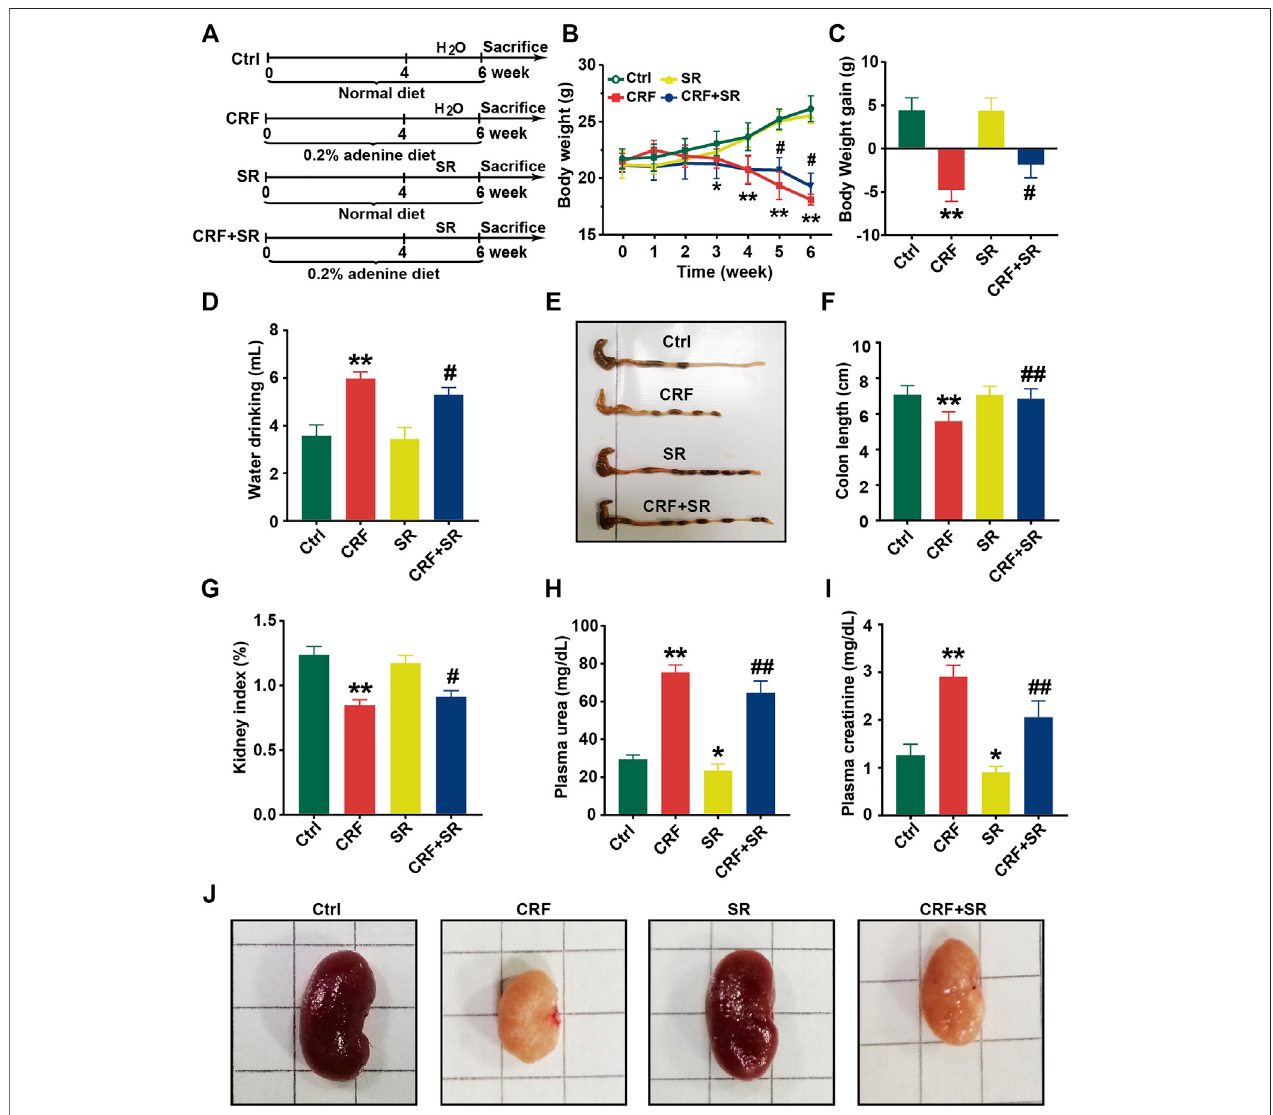
FIGURE 2 | Improvement of physiochemical parameters in adenine-induced CRF mice by SR decoction. (A) Experimental schematic diagram. (B) Growth curve. (C) Bodyweight gain. (D) Water drinking. (E) Macroscopicobservation ofcolon. (F) Measurement ofcolonlength. (G) Kidney index. (H) Level ofplasmaurea. (I) Leveof plasma creatinine. (J) Macroscopic observation of kidney. Data were presented as mean ± SD (n = 8). * p < 0.05, ** p < 0.01 vs. Ctrl group; # p < 0.05, ## p < 0.01 vs. CRF group.